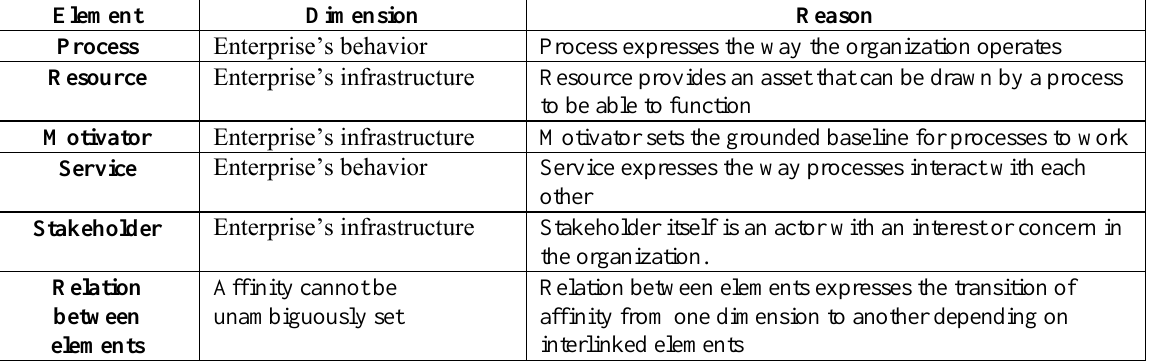
Table 6 . Affinity of constructs to behavioral and infrastructure dimensions of the